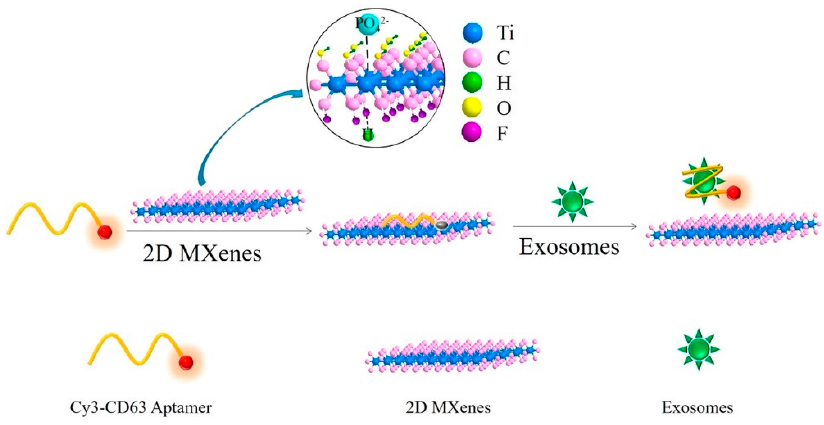
Figure 9. Schematic illustration of the developed fluorescence resonance energy (FRET)-based aptasensor (reprinted with permission from reference [94]).